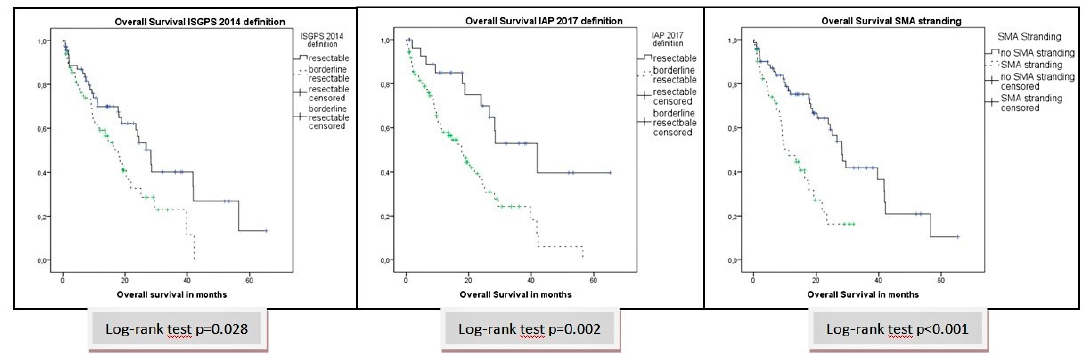
Figure 2. Borderline resectability definitions and overall survival. SMA: superior mesenteric artery; ISGPS: International Study Group of Pancreatic Surgery; IAP: International Association of Pancreatology.